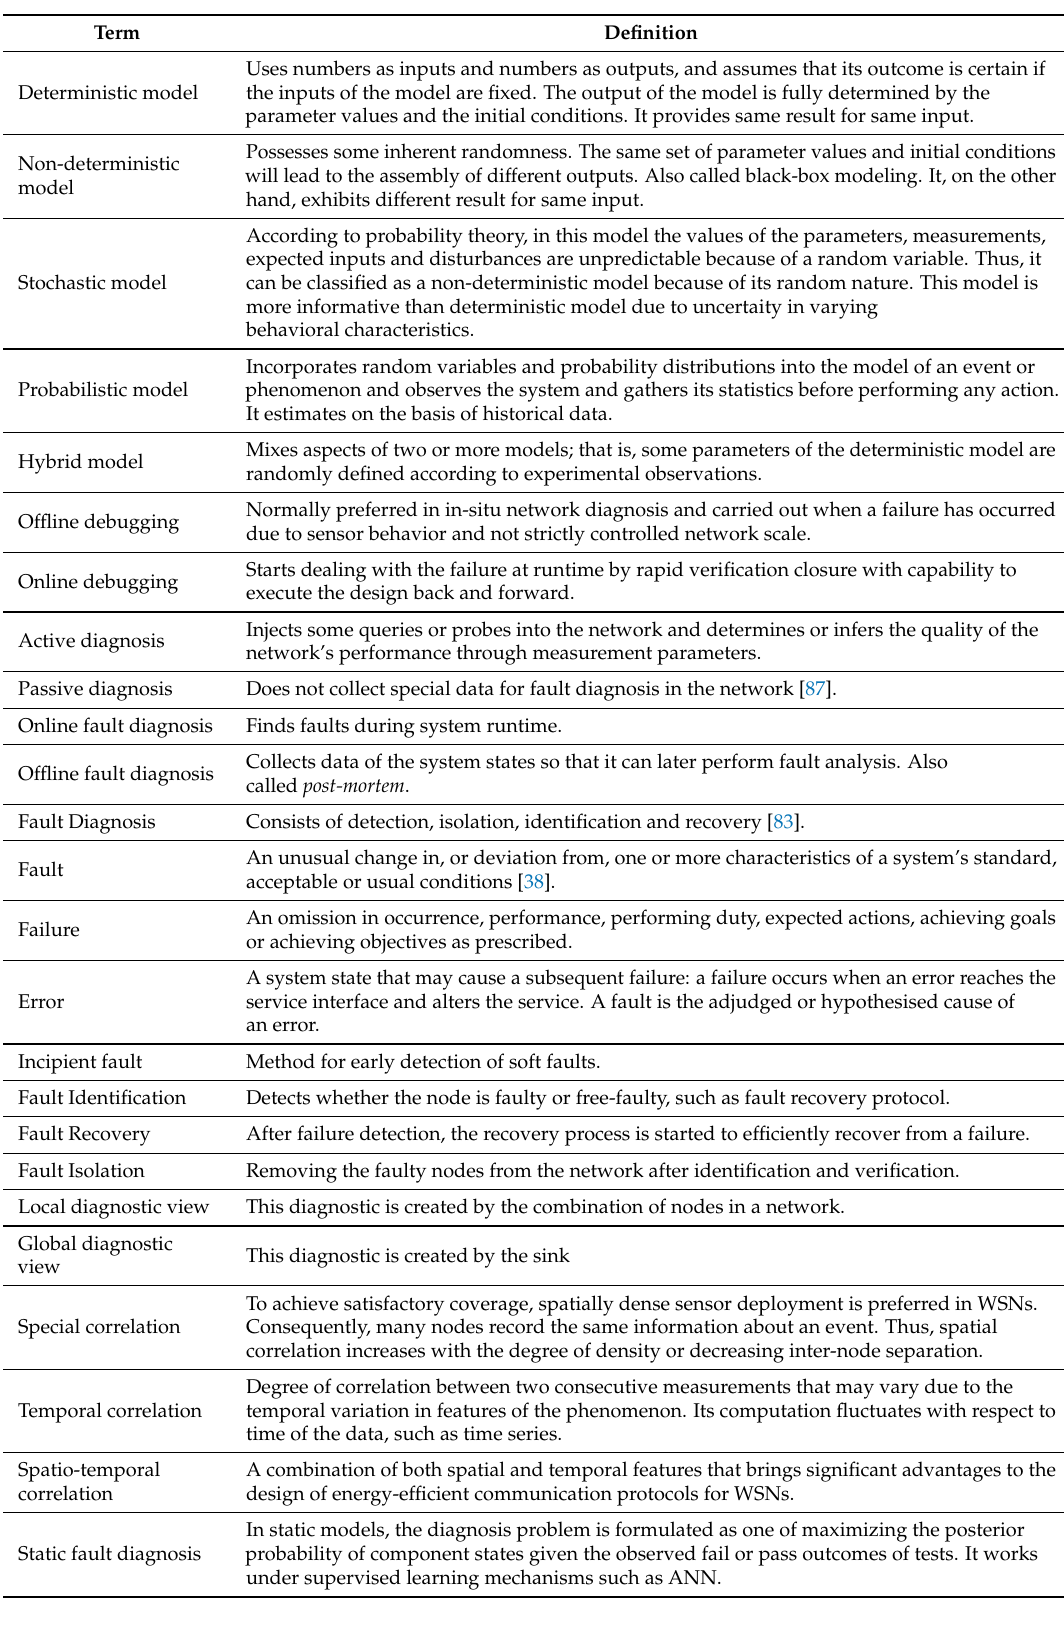
Table 2. Brief overview of important fault diagnosis